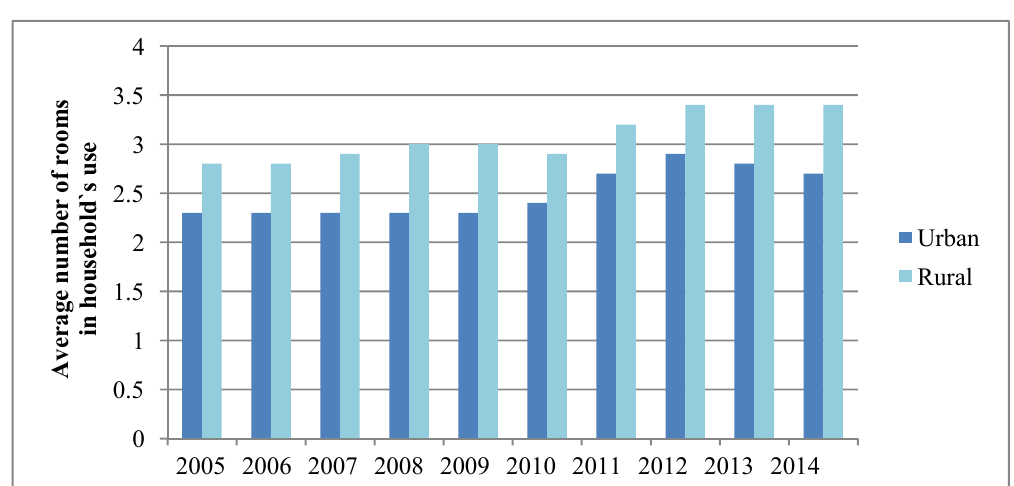
Fig. 4. Average number of rooms used by households in Latvia in urban and rural areas (made by the authors, using the Central Statistical Bureau of Latvia,